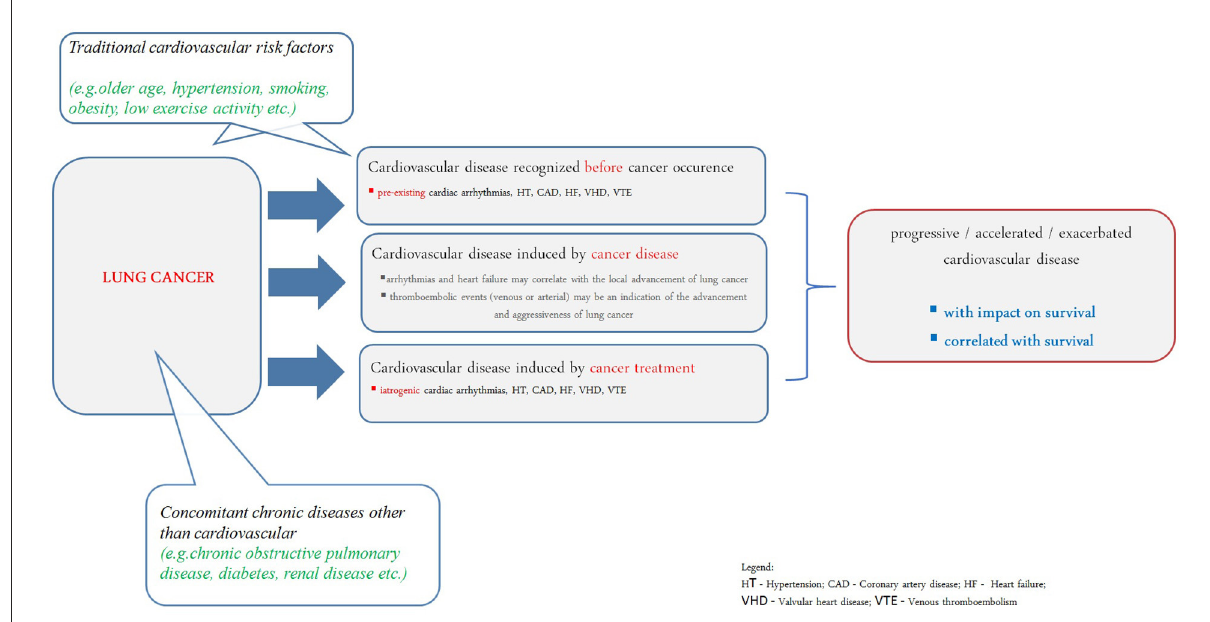
FIGURE1 Understanding of cardiovascular disease in prognosis of lung cancer patients. HT, hypertension; CAD, coronary artery disease; HF, heart failure; VHD, valvular heart disease; VTE, venous thromboembolism.